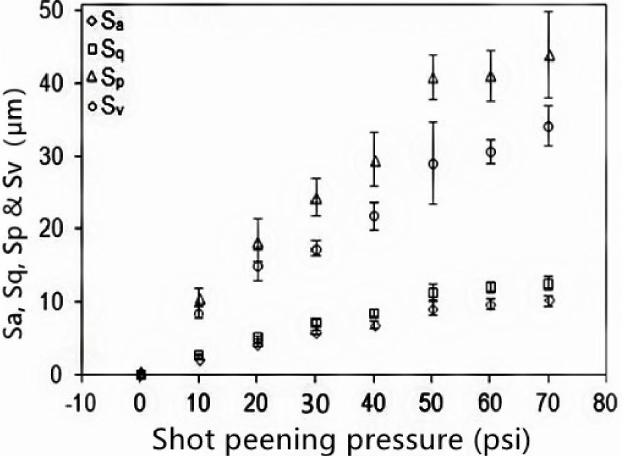
Figure 5. S a , S q , S p and S v values of shot-peened surfaces of AA7075-T6 with various shot peening pressures